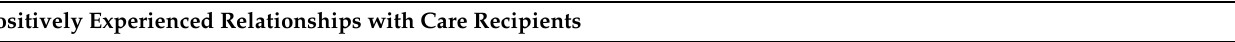
Table 1. Examples of statements made in multi-stage focus group discussions about workplace relationships with care recipients, colleagues. and